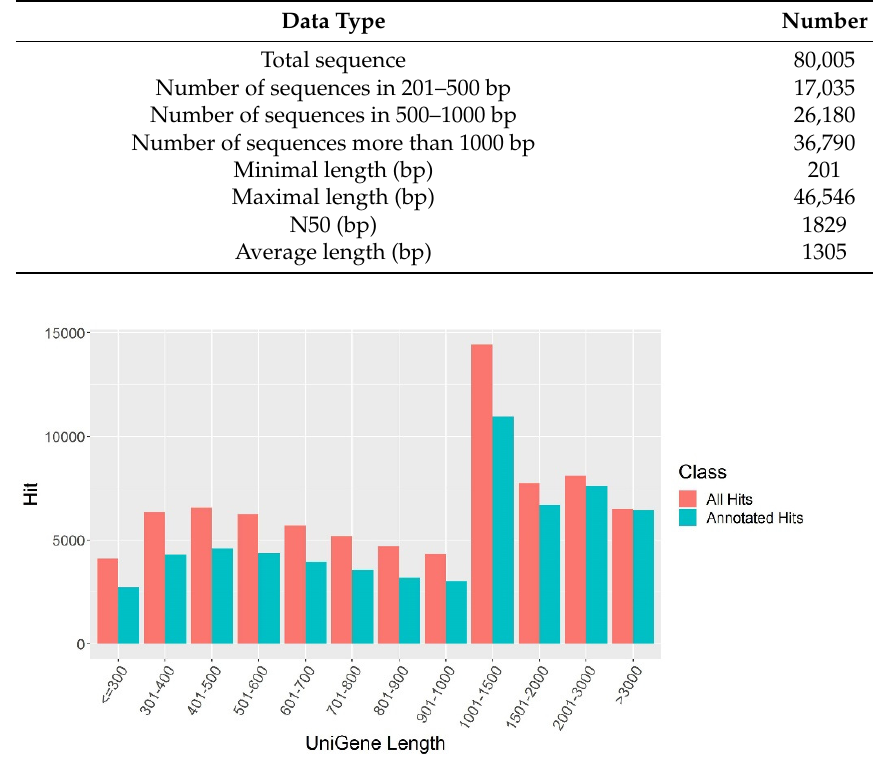
Figure 2. Length distribution of unique transcripts in alfalfa. Note: The X -axis lists the length of alfalfa transcripts, and the Y -axis lists the numbers of alfalfa transcripts. The red bars represent the total number of alfalfa transcripts in a specific length range, and the adjacent blue bars represent those annotated with model plant genomes.